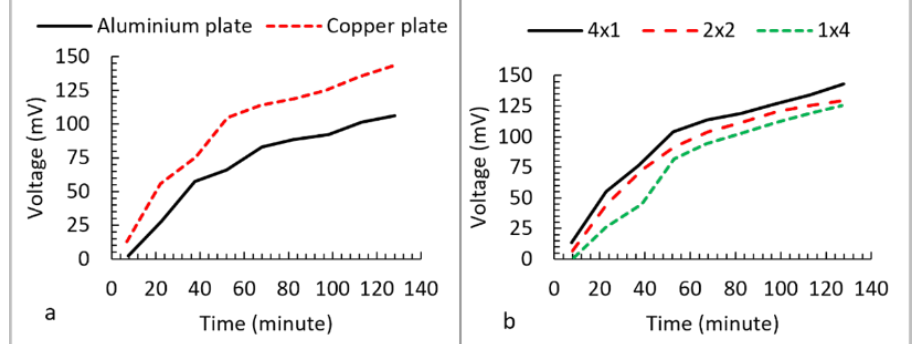
Figure 14. Output voltage vs. time ( a ) different materials, ( b ) different configurations [92].